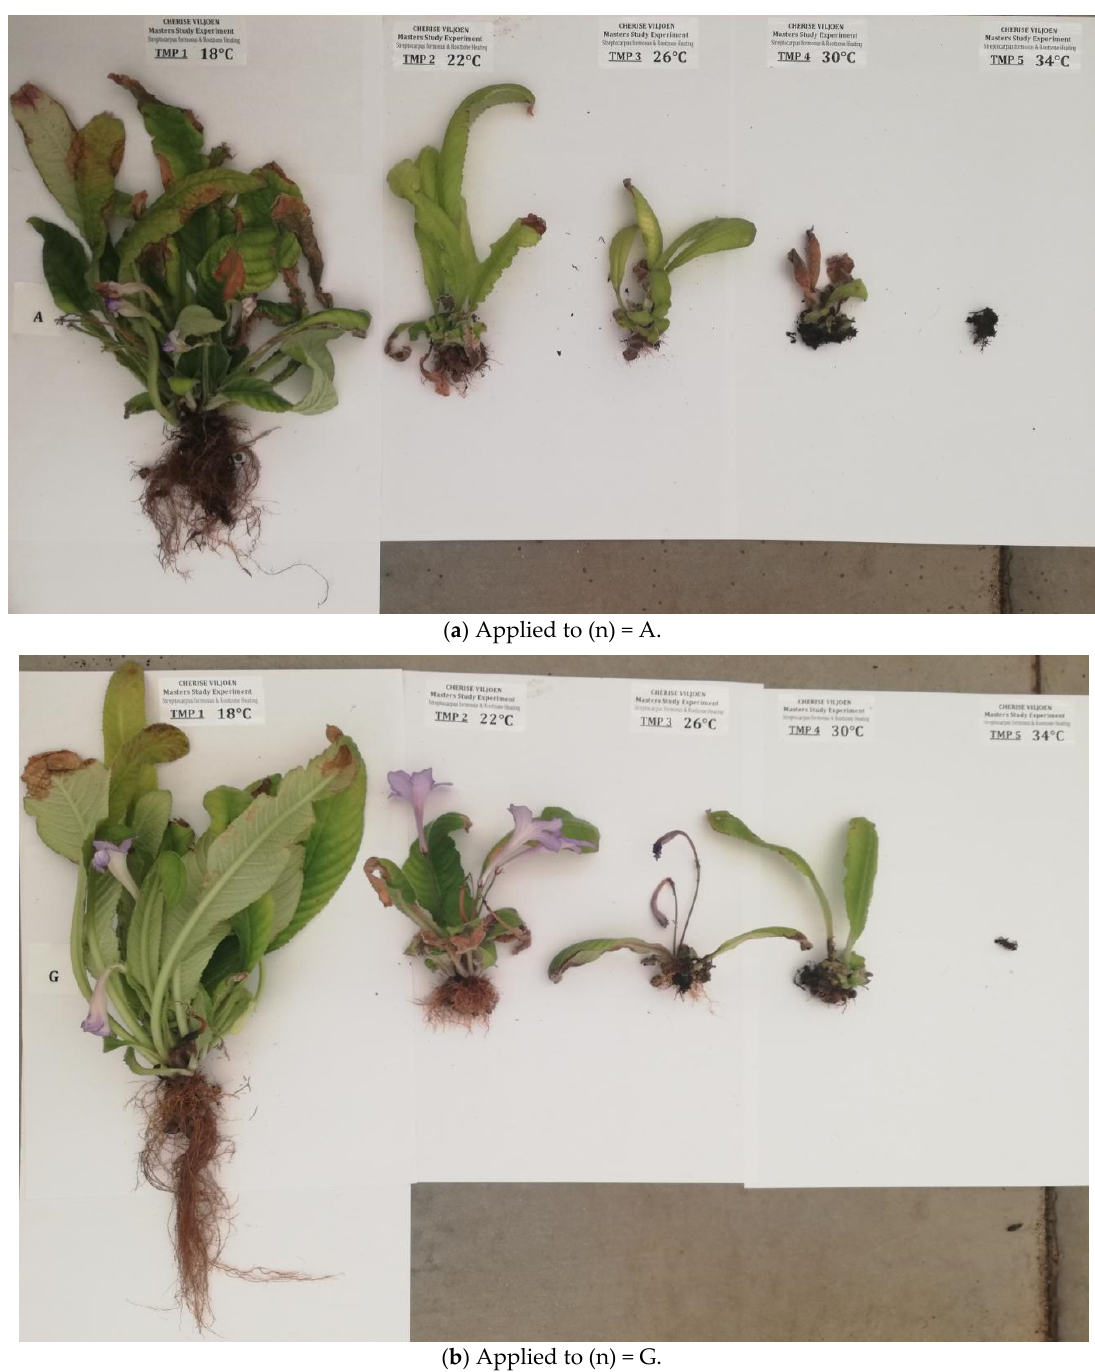
Figure 8. The correlation between all root zone water temperature treatments and the decrease in abscission layers that were present at the start, as compared to the complete absence of abscission layers at the end of the study. Note: Bar graphs presented here are means of the number of abscission layers ±SE. The mean values followed by the same letters are not significantly different (ns) at p ≤ 0.05 as calculated by Fisher’s least significant difference.